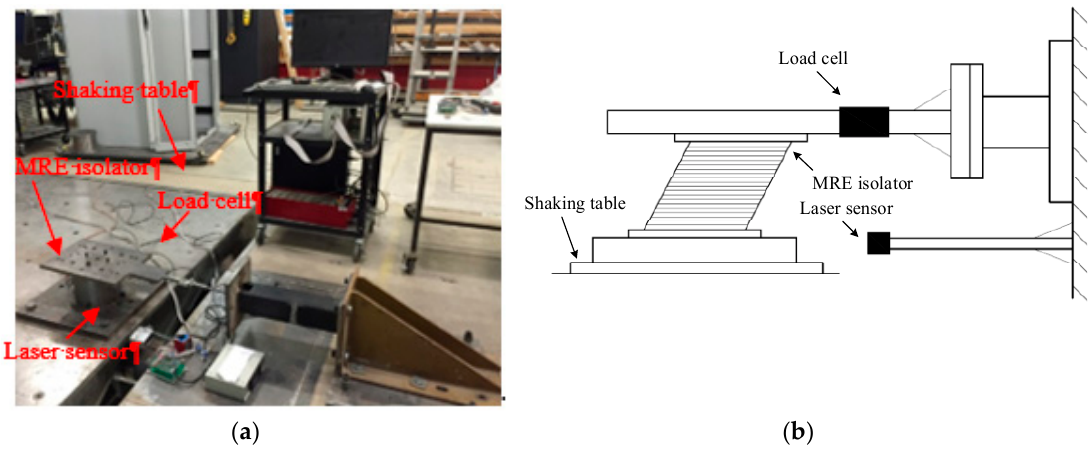
Figure 11. Experimental setup. ( a ) Setup photo; ( b ) Schematic of the setup.